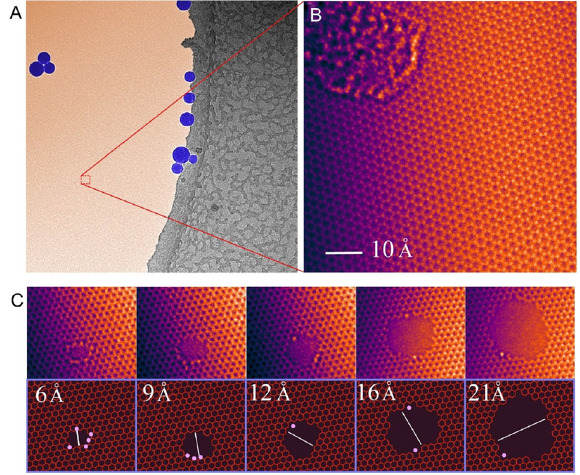
Fig. 12 Un fi ltered TEM images of a suspended graphene with silicon adatoms and the pore-opening process. A The edge of one TEM grid hole covered by a single-layer graphene sample (high- lighted with light orange color). The sample is decorated with SiO 2 nanoparticles (highlighted with deep blue color), mostly clustered on either suspended graphene or the carbon grid. B High-resolution image of the suspended graphene sample showing coexistence of clean pristine graphene and aggregation of impurities (upper left corner). C Images of molecular-scale graphene pores of various sizes, with mobile catalyst Si atoms on the edges. The lower panel images illustrate the corresponding atomic con fi gurations. Reproduced with permission from the American Chemical Society 54